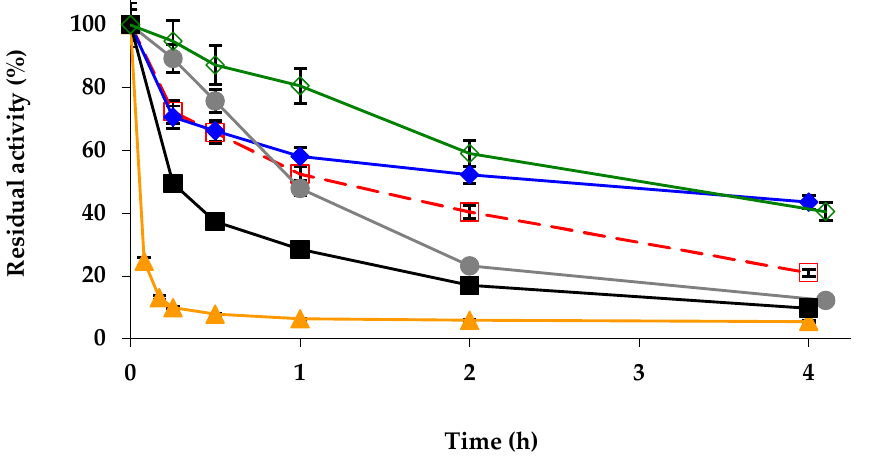
Figure 4. Inactivation courses of different physically and chemically modified octyl-CALB biocata- lysts. The biocatalysts were inactivated at 75 ◦ C in presence of 10 mM Tris-HCl buffer at pH 7.0. Other specifications are described in Methods. Unmodified octyl-TLL (empty squares and dashed and red line); octyl-TLL modified with 1% glutaraldehyde (solid rhombus and solid blue line); amination using 2 M ethylenediamine (solid triangles and solid orange line); 1 mM picrylsulfonic acid (solid circles and solid grey line); 10% polyethylenimine (solid squares and solid black line); 10% dextran sulfate (empty rhombus and solid green line).